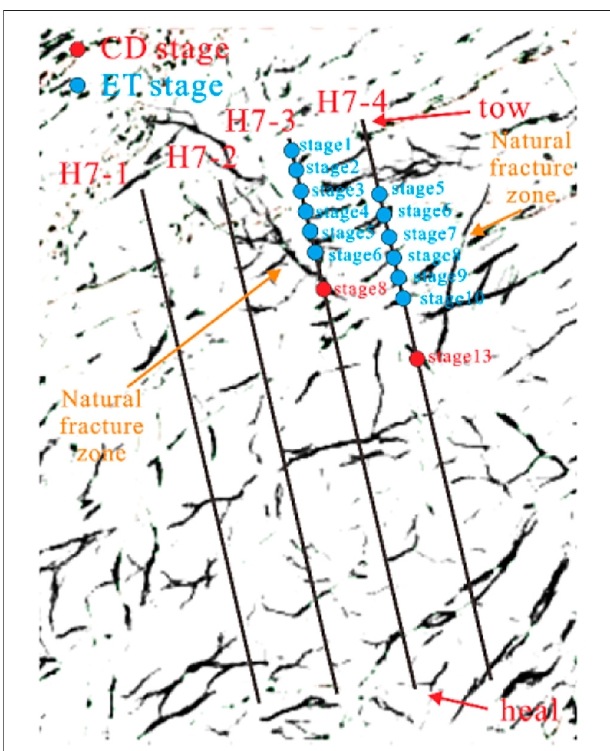
FIGURE 6 | Location distribution and natural fracture development characteristics of fore-sequence excited stage groups and casing deformation stages in H7